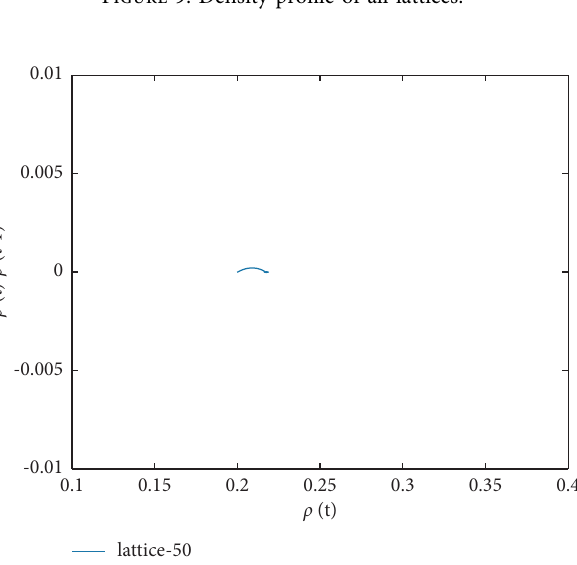
Figure 9: Density profile of all lattices.